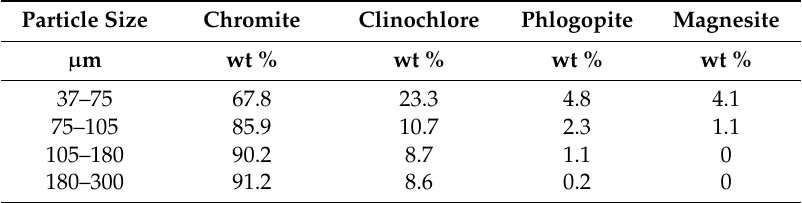
Table 1. Mineralogical compositions of the chromite ores of four size